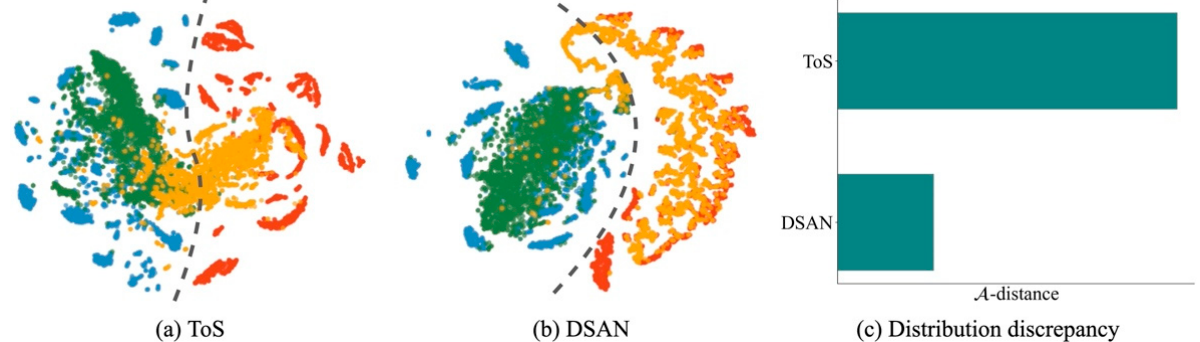
Figure 6. Visualizations of the learned feature representation using t-SNE on Fire-DA and the testing set of FD-dataset, ( a ) w/o domain adaptation, and ( b ) w/ domain adaptation. The red and yellow circles represent fire samples in Fire-DA and the testing set of FD-dataset, respectively. The blue and green circles represent non-fire samples in Fire-DA and the testing set of FD-dataset, respectively. The grey dashed lines indicate possible classification boundaries. ( c ) Distribution discrepancy between Fire-DA and the testing set of FD-dataset measured by A-distance.